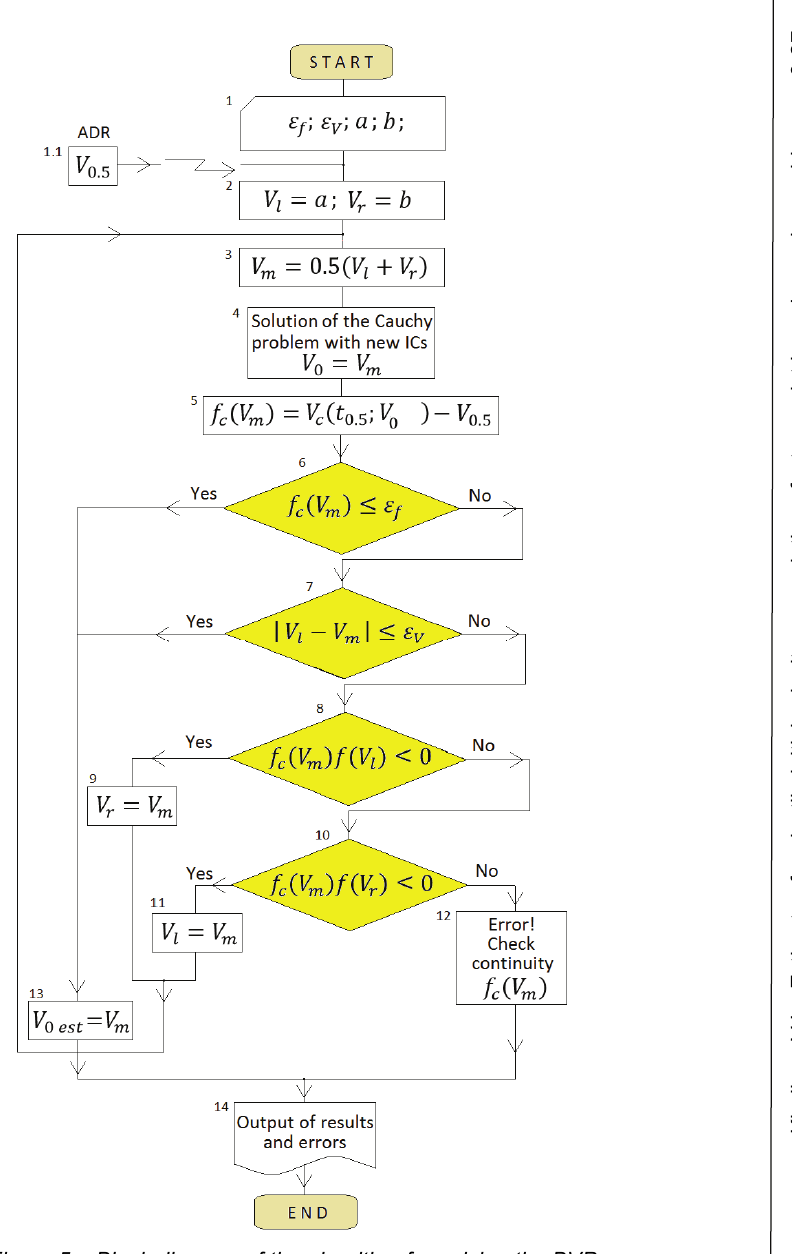
Figure 5 – Block diagram of the algorithm for solving the BVP Рис . 5 – Блок - схема алгоритма решения граничной задачи Слика 5 – Шема алгоритма за решавање проблема граничне